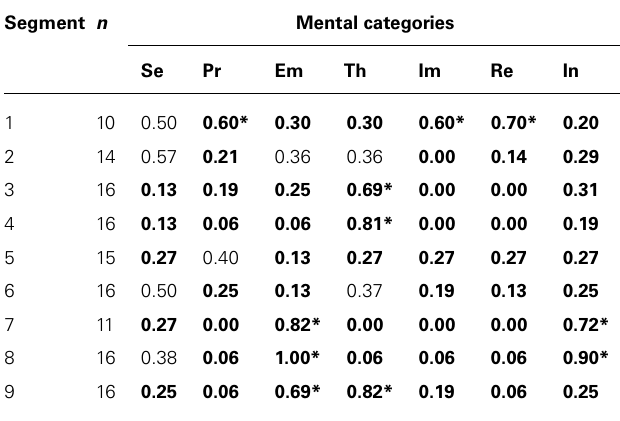
Table 1 | Mental term (categories) attribution to a phenomenological text (excerpt from the “Intimate Journal” of Unamuno).